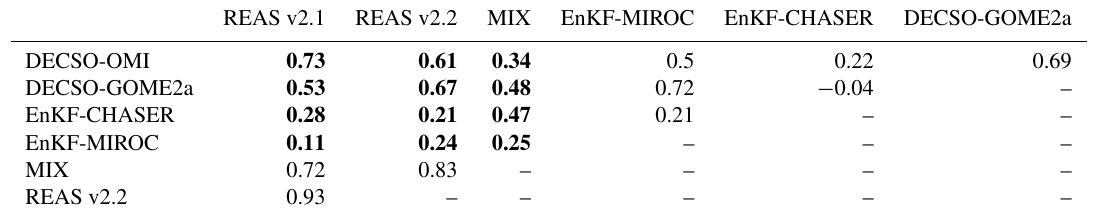
Table 3. Temporal correlation coefficient of the 12 pairs of monthly total NO x emissions over urban areas in the common year 2008. The bold values indicate the relation between bottom-up and satellite-based inventories.